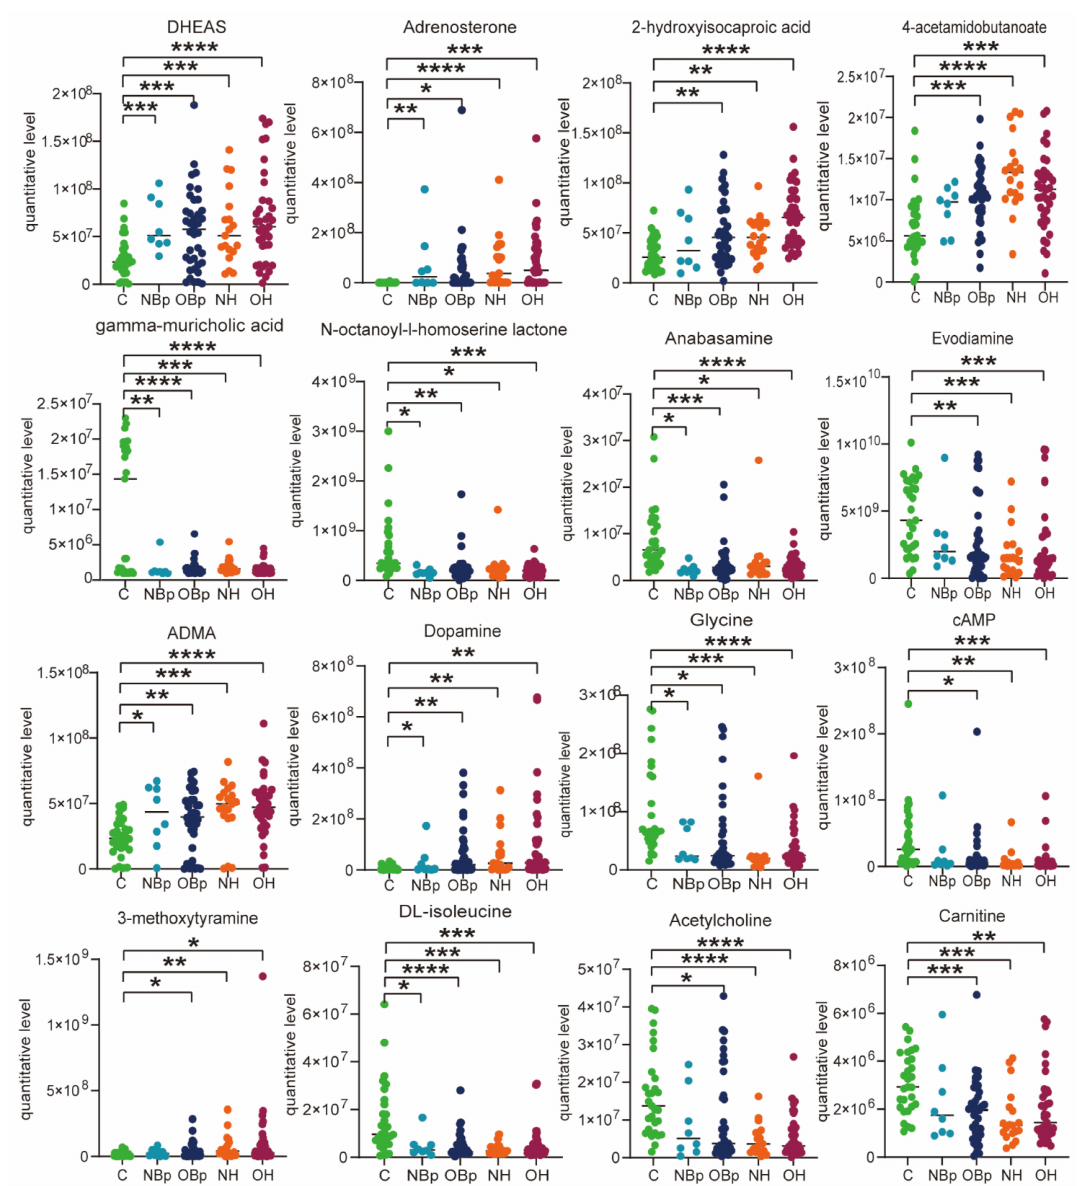
Figure 2. Scatter diagram of hypertension-related metabolites. DHEAS: 3-dehydroepiandrosterone sul- fate. ADMA: NG, NG-dimethyl-L-arginine. cAMP: adenosine 3 (cid:48) ,5 (cid:48) -cyclic monophosphate. Comparison of differential metabolites among the five groups. (* p < 0.05, ** p < 0.01, *** p < 0.001, **** p < 0.0001). For the OBp group, phenylpropanoids and polyketides, organic acids and deriva- tives, benzenoids, lipids and lipid-like molecules and organoheterocyclic compounds were up-regulated and down-regulated to varying degrees (Figure 4A). In lipids and lipid-like metabolites, adrenosterone, beta estradiol, 1-hexadecanoyl-2-octadecadienoyl-sn-glycero-3 phosphocholine, 1-oleoyl-2-myristoyl sn-glycero-3 phosphocholine, artesunate, DHEAS, and 2-hydroxyisocaproic acid were up-regulated; 1-myristoyl-sn-glycero-3-phosphocholine, 19-hydroxyandrost-4-ene-3,17-dione, estra-1,3,5(10),7-tetraene-3,17beta-diol, and